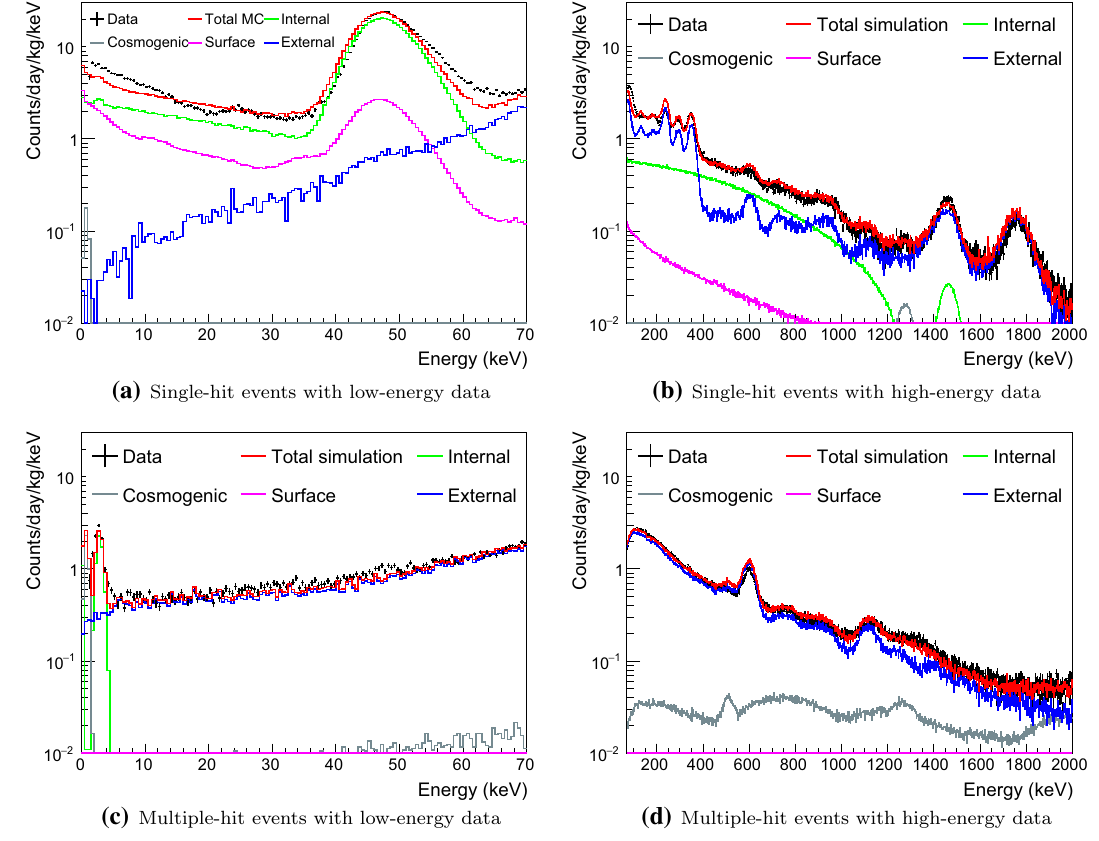
Fig. 2 Measured single- and multiple-hit background spectra of Crystal-1 fitted with all simulated background spectra using four channel simul- taneous fitting. 3 H and 109 Cd are excluded in the fit